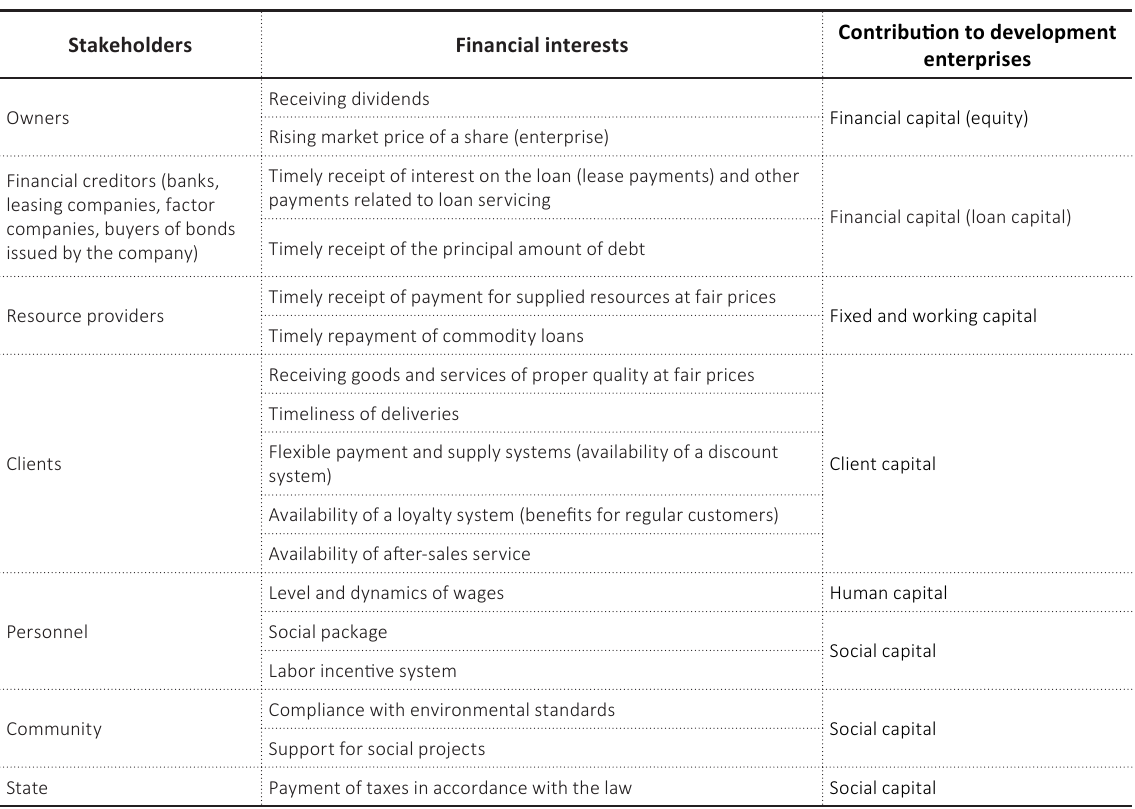
Source: Authors’ elaboration.